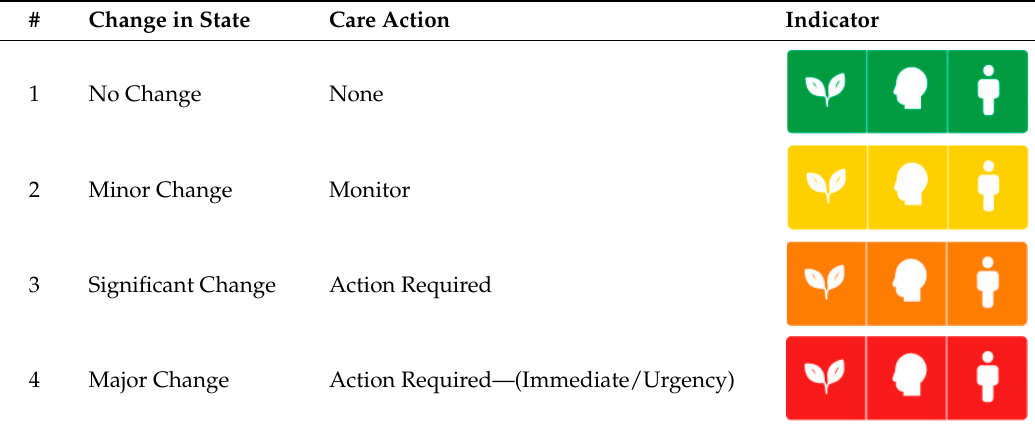
Table 5. Wellness Indicator, Change in State & Care Actions.